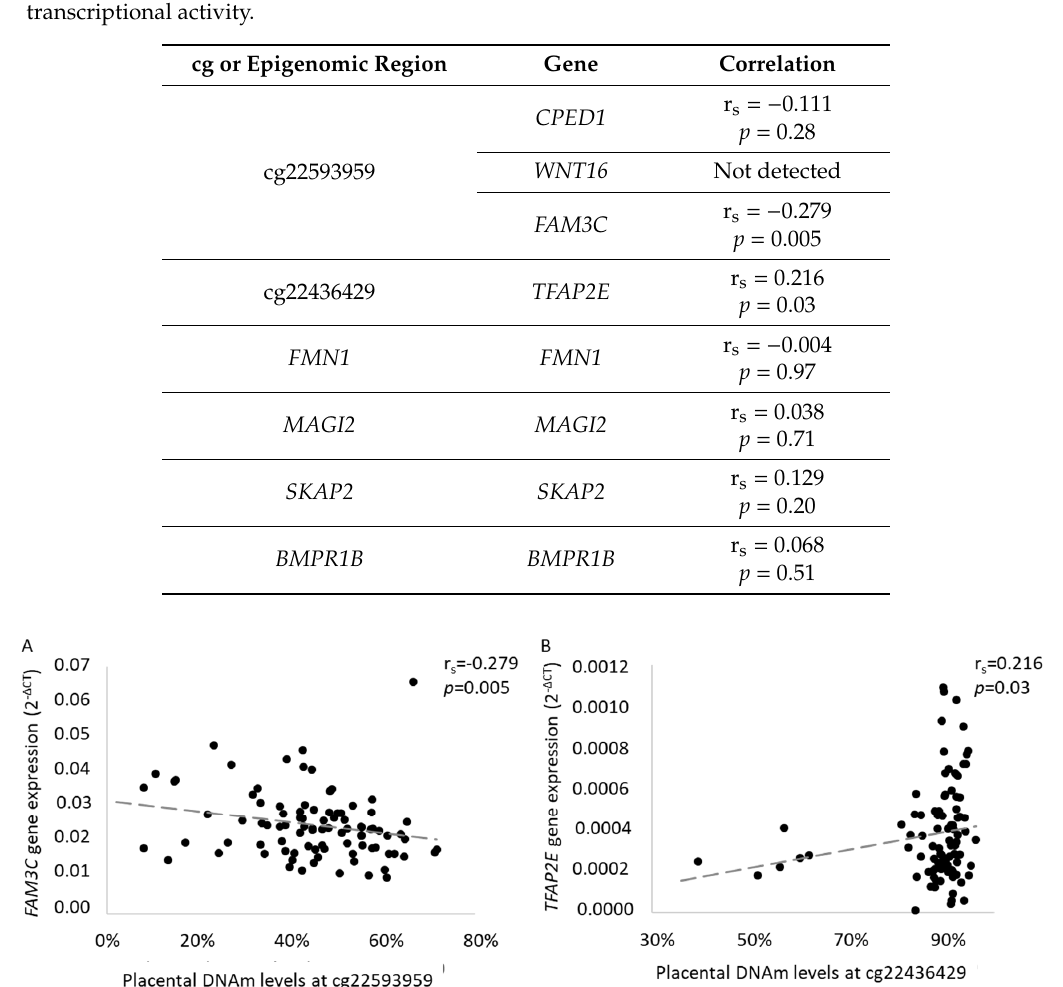
Figure 3. Associations between placental DNAm levels between ( A ) cg22593959 and FAM3C mRNA levels and ( B ) cg22436429 and TFAP2E mRNA levels. Spearman’s correlation tests were computed for